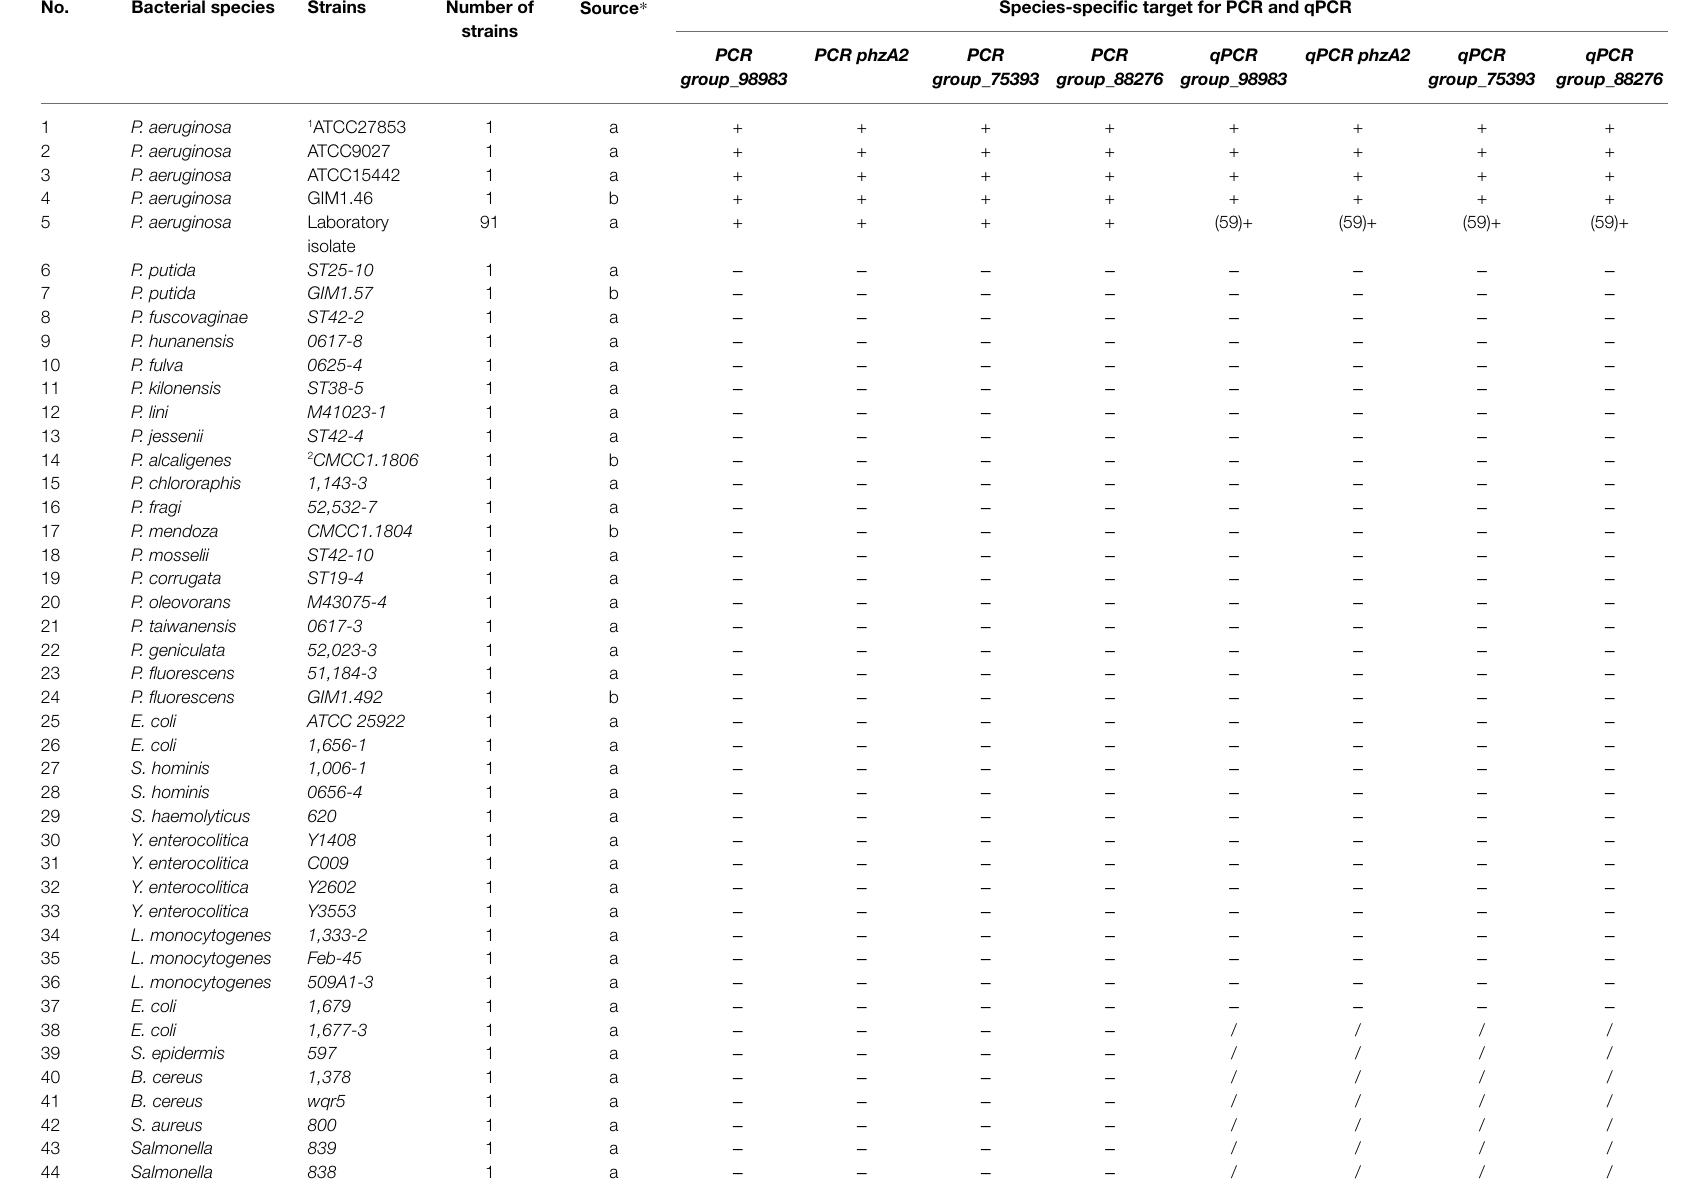
TABLE 2 | Specificity results for PCR primers using P. aeruginosa and other foodborne pathogenic strains.